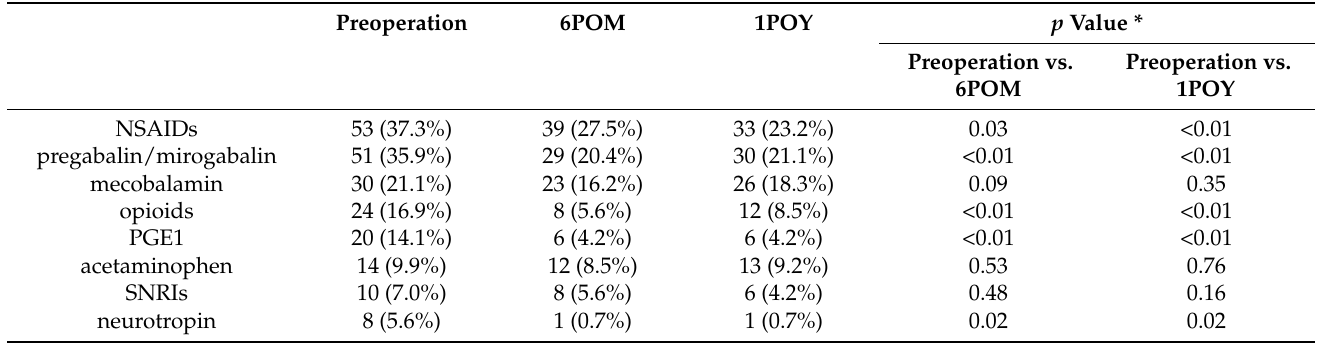
Table 3. Proportion of patients taking each LSCS medication before and after surgery ( n =